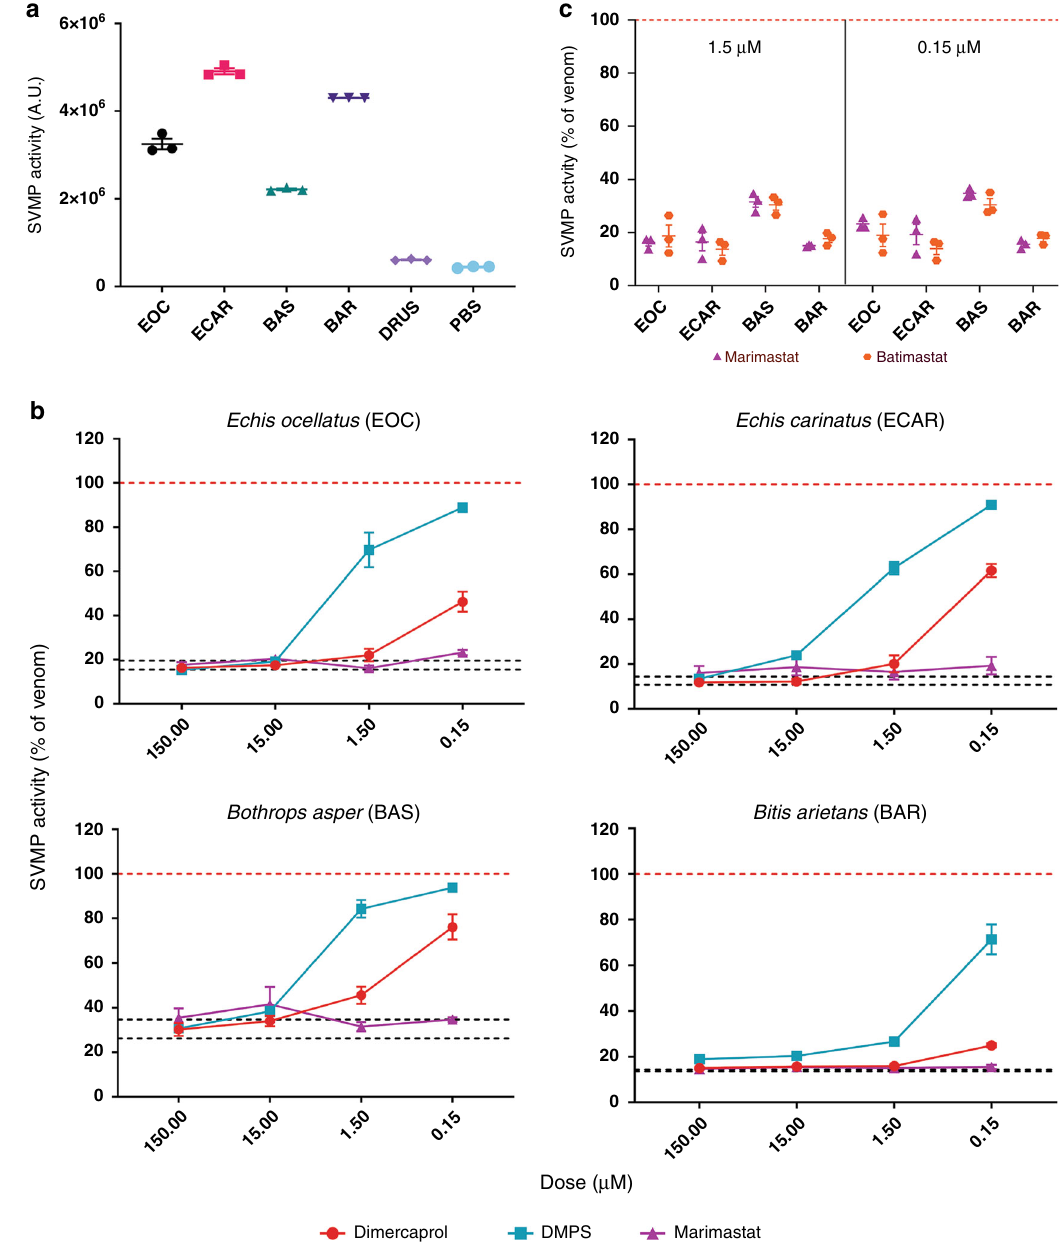
Fig. 2 Small molecule toxin inhibitors inhibit the in vitro SVMP activities of several geographically distinct viper venoms. a SVMP activities of the fi ve viper venoms quanti fi ed by fl uorogenic assay. The data presented represent mean measurements and SEMs of area under the curves of fl uorescent arbitrary units taken from three independent experimental runs. EOC E. ocellatus ; ECAR E. carinatus ; BAS Bothrops asper ; BAR Bitis arietans ; DRUS Daboia russelii . b The effectiveness of metal chelators and peptidomimetic hydroxamate inhibitors at inhibiting the SVMP activity of the various viper venoms. Drug concentrations from 150 µ M to 150 nM (highest to lowest dose tested) are presented. The data is expressed as percentage of the venom-only sample (100%, dashed red line). The negative control is presented as an interval (dashed black lines) and represents the values recorded in the PBS-only samples (expressed as percentage of venom activity), where the highest and the lowest values in each set of independent experiments are depicted. Inhibitors are color-coded (dimercaprol, red; DMPS, turquoise; marimastat, purple). c Comparison of SVMP inhibition by marimastat (purple) and batimastat (orange) at two concentrations (1.5 µ M, left; 0.15 µ M, right), expressed as the percentage of the venom-only sample (100%, dashed red line). All data represent triplicate independent repeats with SEMs, where each technical repeat represents the mean of n ≥ 2 technical replicates. Source data provided in Supplementary Data